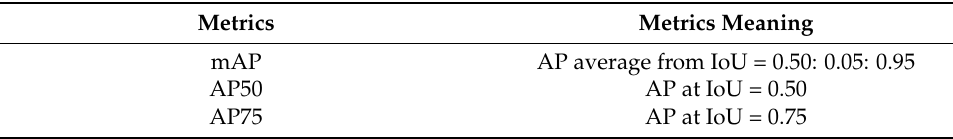
Table 2. Evaluation Metrics used in this